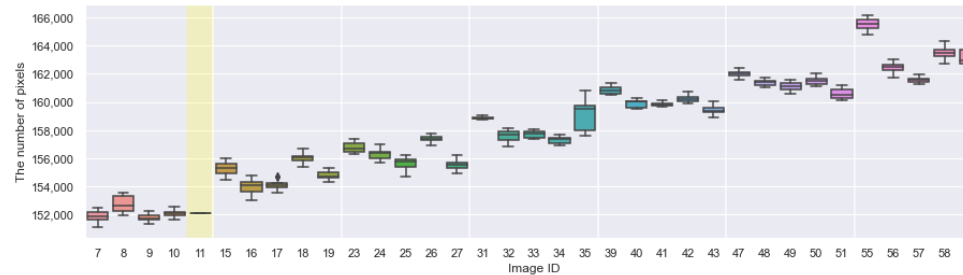
Figure A1. 13–19 August.